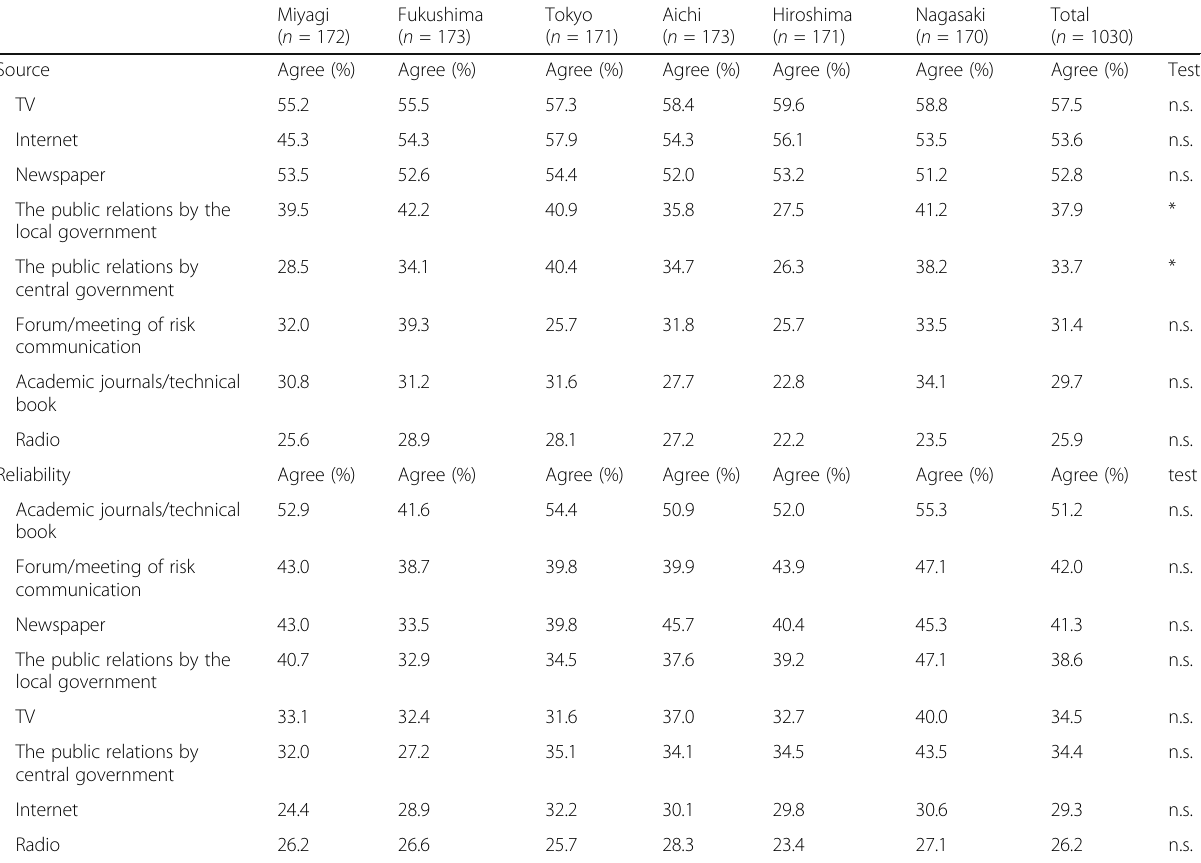
Table 8 Difference in the percentage of “ Agree ” on the sources of information regarding radiation and its reliability among residents of the six